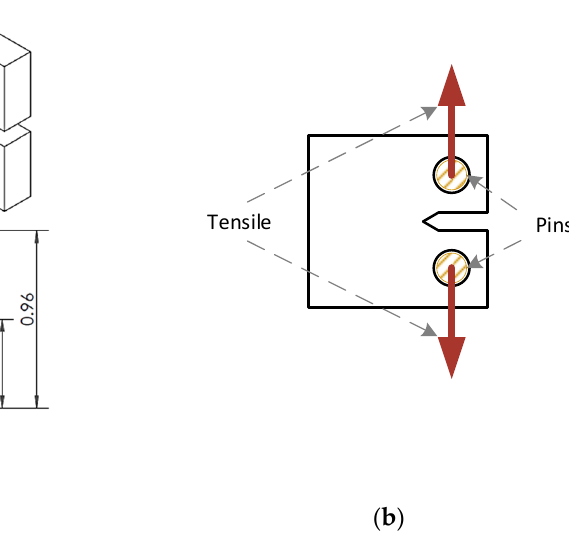
Figure 1. Tested specimen: ( a ) design (unit: in); ( b ) applying tensile.